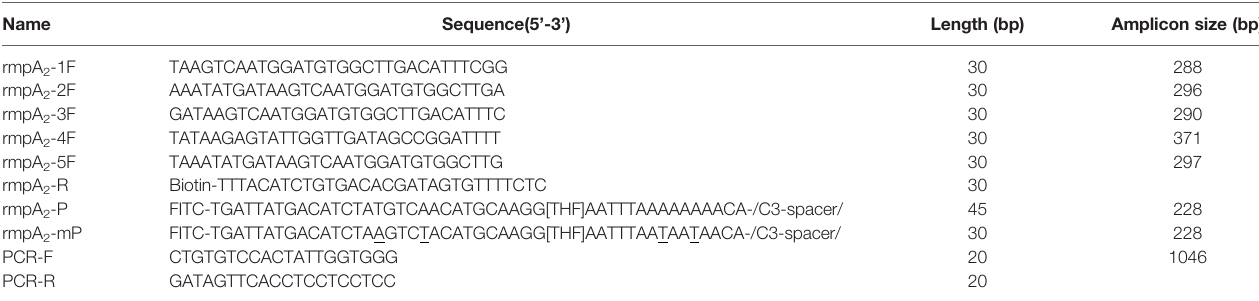
TABLE 1 | Primers and probes tested in this